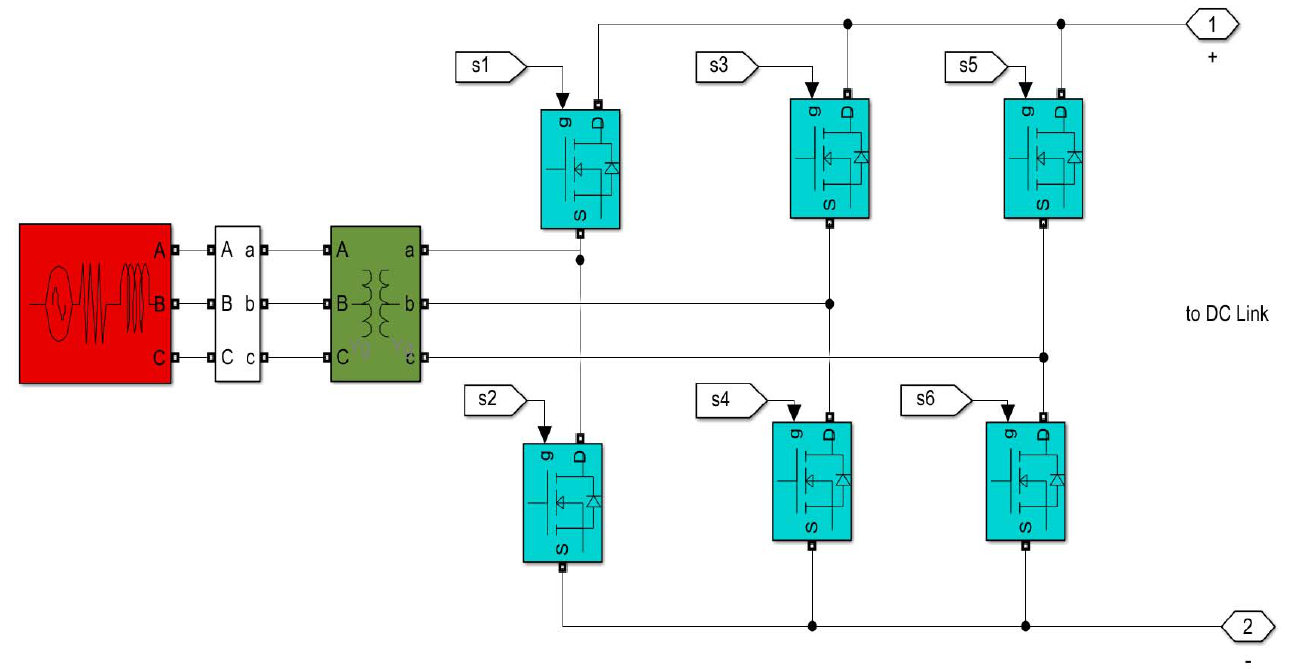
Figure 3. DC link rectifier. Figure 3. DC link